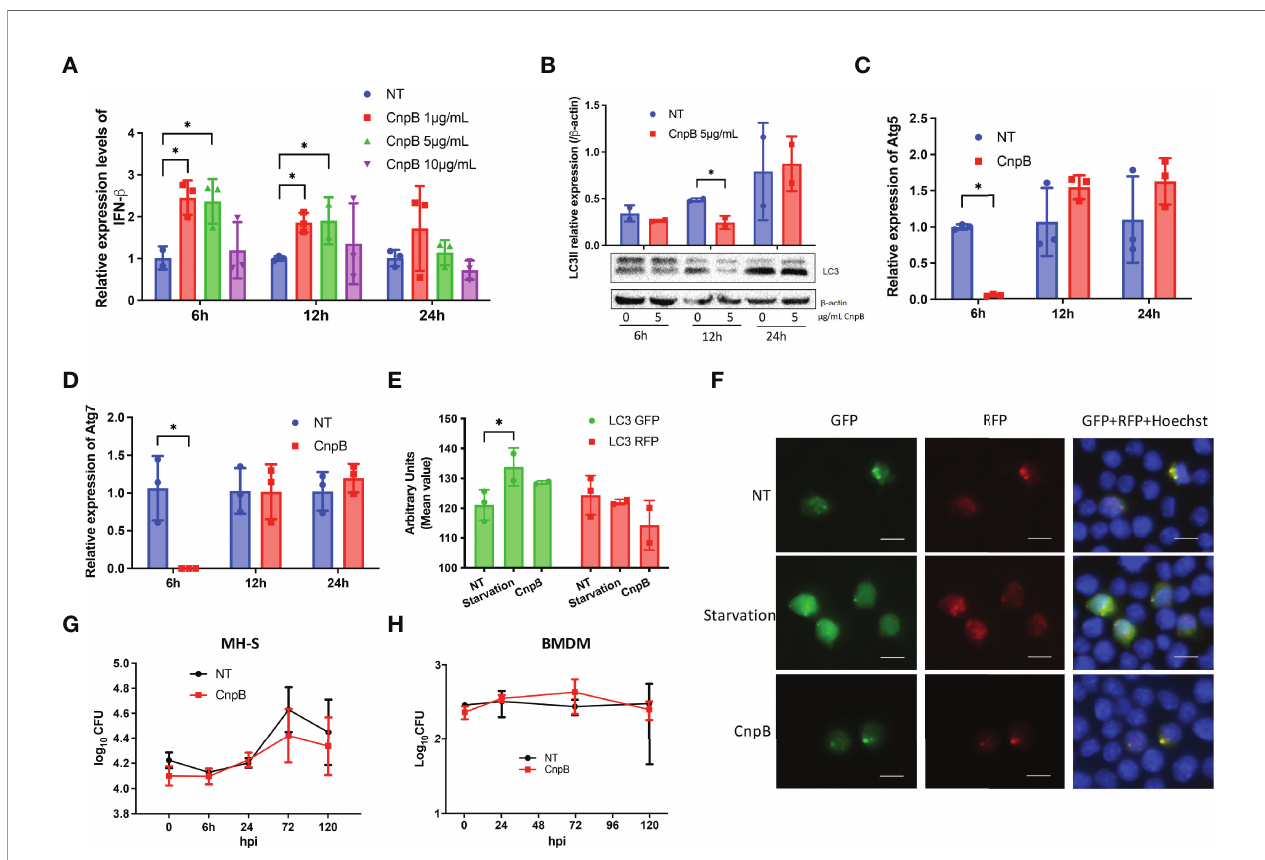
FIGURE 4 | Type I IFN and autophagy responses stimulated by CnpB in macrophages. (A) In MH-S cells, IFN- b transcriptional levels were analyzed by qRT-PCR at 6 h, 12 h, and 24 h post-stimulation with different doses of CnpB ( n =3). NT, no treated. (B) LC3-I/II protein levels were analyzed by Western-blot post-stimulation with different doses of CnpB ( n =2). NT, no treated. The fi gure shown is a representative of two repeat experiments. (C , D) Atg5 and Atg7 transcriptional levels were analyzed by qRT-PCR at 6 h, 12 h, and 24 h post 5 m g/mL CnpB stimulation ( n =3). (E , F) MH-S cells transfected with RFP-GFP-LC3 plasmids and LC3 puncta were analyzed by immuno fl uorescence post-CnpB stimulation for 4 h. Semi-quantitative analysis of panel (F) showed in panel (E) . RFP, red fl uorescence protein. GFP, green fl uorescence protein. Scale bar is 50 m m ( n =3). (G, H) MH-S cells in 24-well microplates (G) and BMDM cells in 96-well microplates (H) were treated with 5 m g/mL CnpB for 12 h, then cells were infected with M. tuberculosis H37Ra at MOI of 1 ( n =2 or 3). Bacteria were removed 4 h post-infection, this time point is termed as “ 0 h ” . Bacteria CFUs were determined at indicated time points post-infection. The results are expressed as mean ± SD. * P <